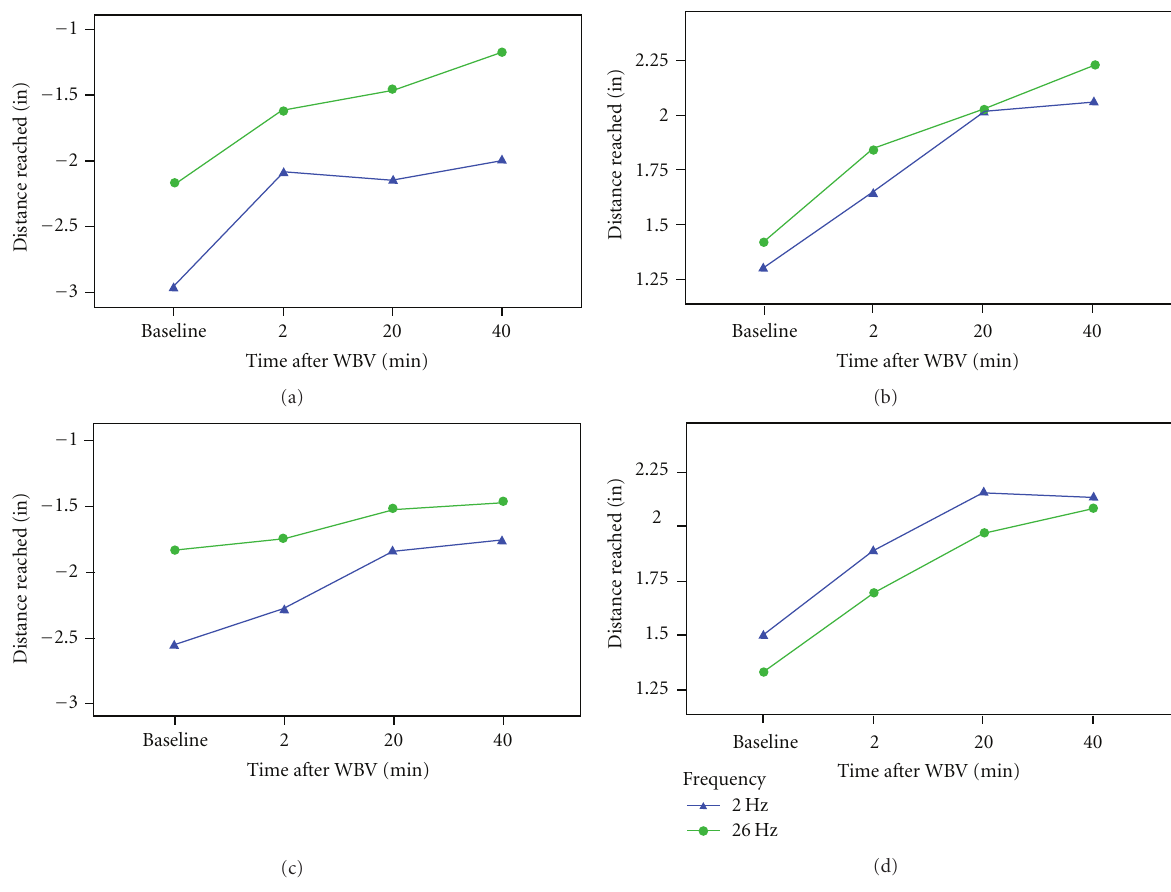
Figure 4: Time course of chair sit and reach (CSR) on the left side in males (a) and females (b) and CSR on the right side in males (c) and females (d) at 2 Hz and 26Hz